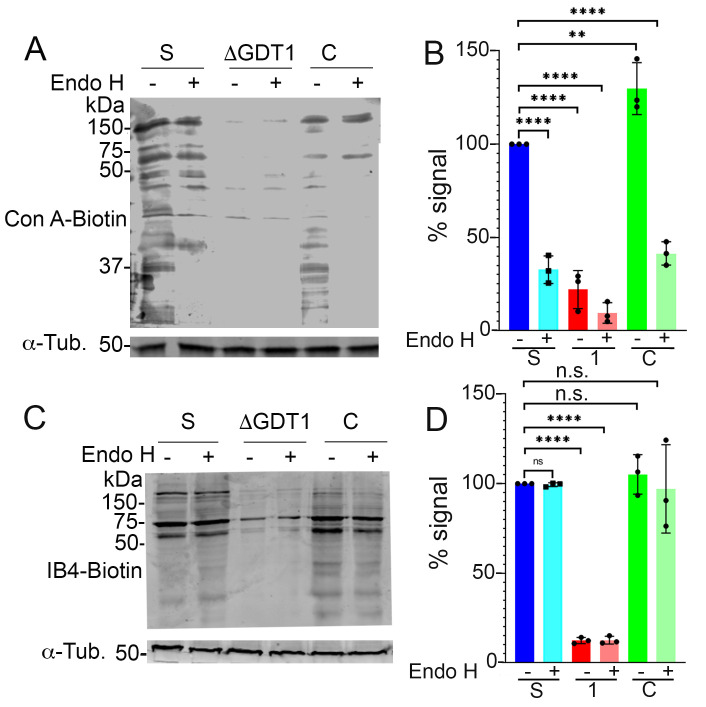
Concanavalin A-biotin, and IB4-biotin staining.(A) Western blot analysis using biotin conjugated concanavalin-A in epimastigotes of control (S) or TcGDT1-KO clones either untreated or treated with endoglycosidase H (endo H). Upon ConA labelling, the smearing of the control lanes (S) disappear in the TcGDT1-KO clones indicating reduced glycosylation. This smearing is again visible to some extent in the complemented (C) cell line. Anti-tubulin (Tub) was used as loading control. (B) The intensity of bands in (A) was quantified by normalizing ConA signal to the tubulin signal and expressed graphically as a percentage of signal from the control. Values are means ± s.d., n = 3, **p < 0.01; ***p < 0.005; ****p < 0.0001. Statistical analyses were performed using one-way ANOVA and Turkey’s multiple comparisons test. (C) Western blot analysis using biotin conjugated isolectin-B4 in epimastigotes of control (S) or TcGDT1-KO clones either untreated or treated with endoglycosidase H (endo H). Upon isolectin-B4 labelling, the smearing of the control lanes (S) disappear in the TcGDT1-KO clones indicating reduced glycosylation. This smearing is again visible to some extent in the complemented (C) cell line. Anti-tubulin (Tub) was used as loading control. (D) The intensity of bands in (C) was quantified by normalizing isolectin B4 signal to the tubulin signal and expressed graphically as a percentage of signal from the control. Values are means ± s.d., n = 3, **p < 0.01; ***p < 0.005; ****p < 0.0001. Statistical analyses were performed using one-way ANOVA and Turkey’s multiple comparisons test.